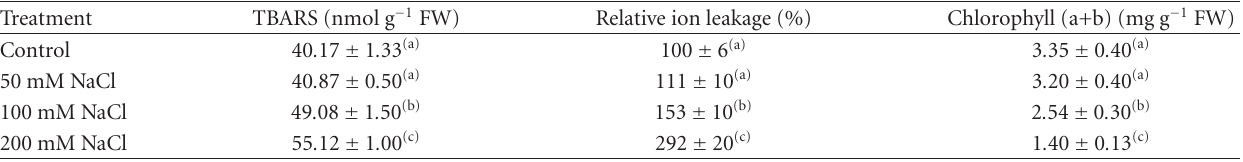
Table 1: E ff ect of di ff erent salt concentrations on TBARS levels, ion leakage and chlorophyll content.